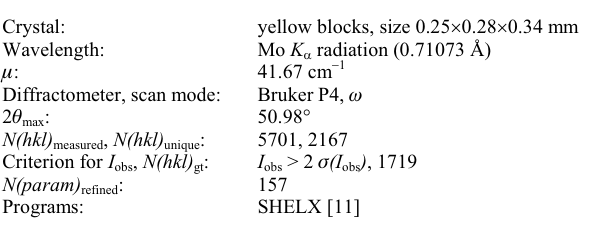
Table 1. Data collection and handling.